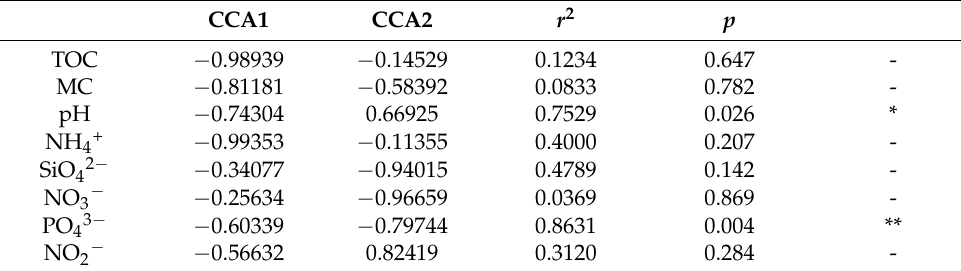
Figure 4. Canonical correspondence analysis of bacterial community. Dots with different colors represent different sampling sites, arrows represent geochemical properties, and the longer the length, the greater the correlation between the geochemical property and the sample distribution. Table 2. A Monte Carlo permutation test for geochemical properties and bacterial community.